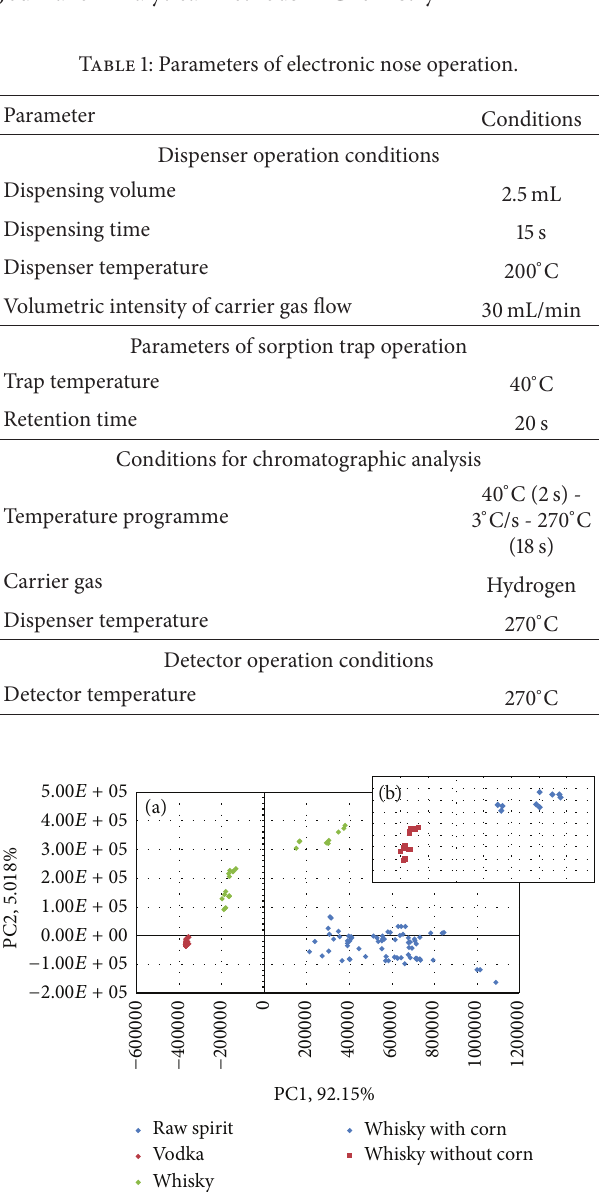
Figure 1: (a) PCA results for vodkas, whiskies, and raw spirits; (b) PCA results for vodkas, whiskies made from corn, whisky made without corn, and raw